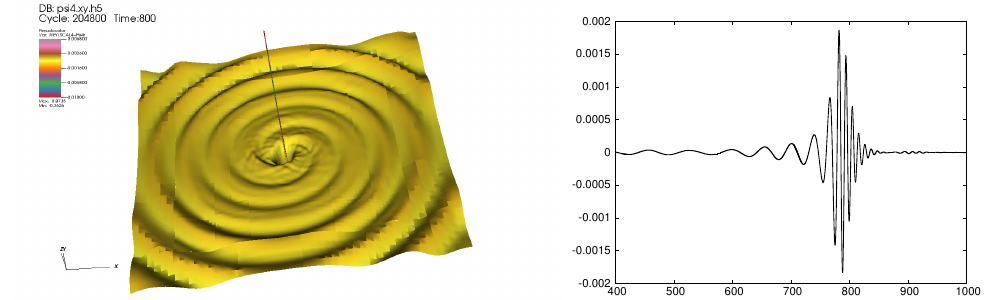
Figure 3. Visualization of the spacetime curvature just after the black hole merger, described by the Weyl scalar ψ 4 , which shows the outgoing radiation for asymptotically flat spacetime ( left ), and an exemplary GW signal that can be detected in the instrument, shown by the time dependence of the real part of the l = 2, m = 2 components of ψ 4 ( right